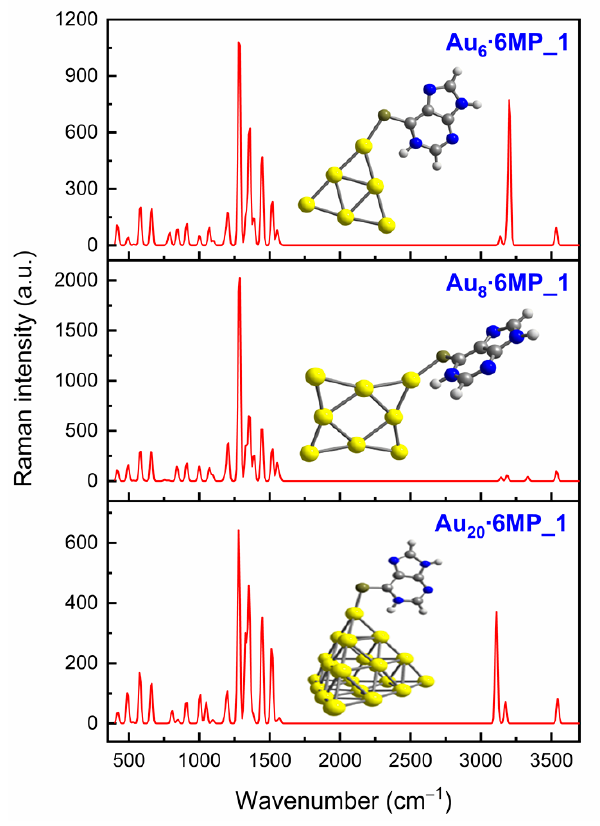
Figure 8. Comparison of 6MP SERS spectra adsorbed on small Au n clusters with n = 6, 8, 20. Simulations are performed in an aqueous solution.